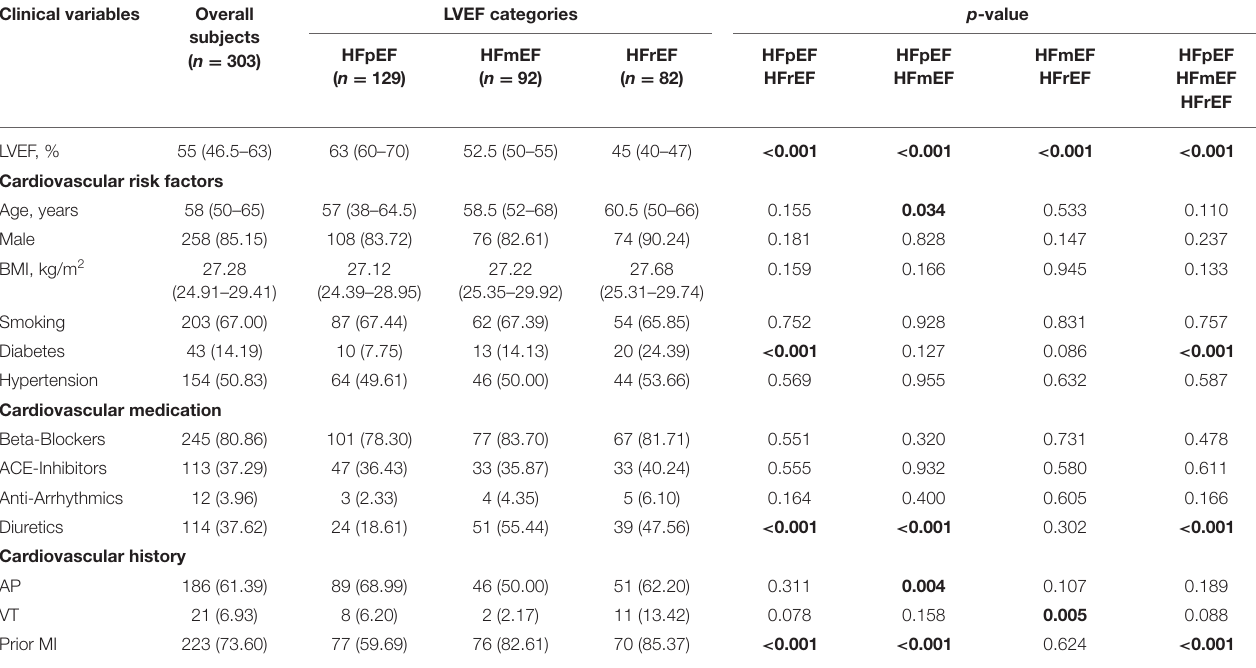
TABLE 1 | Clinical characteristics of the heart failure patients based on their left ventricular ejection fraction categories. Clinical variables